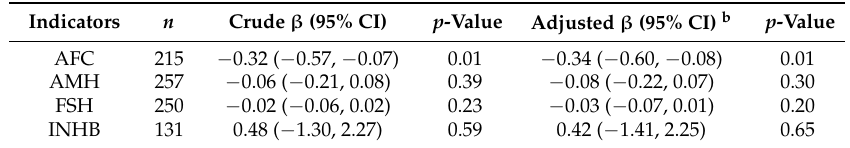
Table 2. The association of urinary BPA levels a with antral follicle count, antimullerian hormone, day-3 follicle stimulating hormone and inhibin B